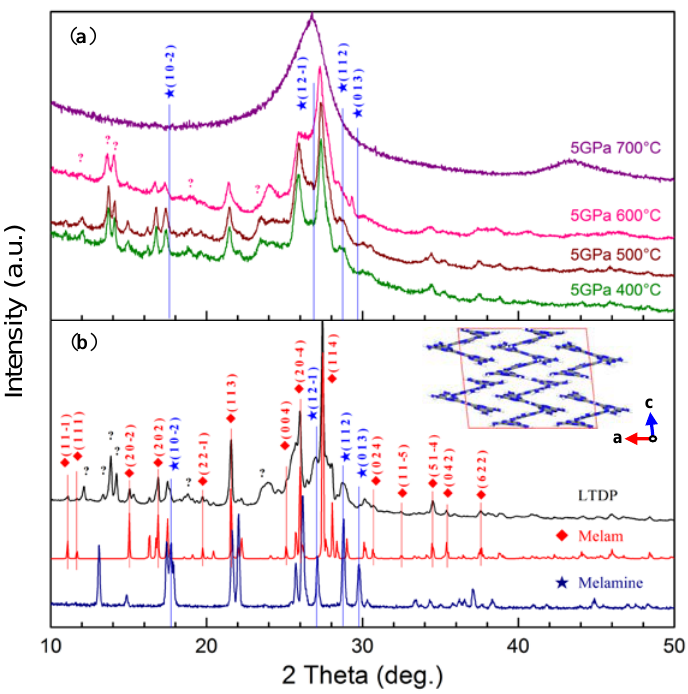
Figure 1. ( a ) XRD patterns of the samples treated at 5 GPa and different temperatures (400, 500, 600, and 700 °C); ( b ) XRD patterns of melamine, melam and LTDP sample. The inset in ( b ) Shows the crystal structure of melam.